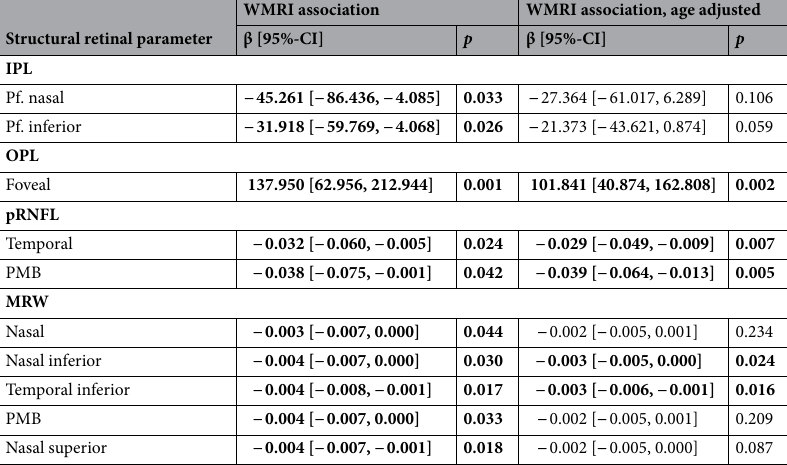
Table 3. Results of linear regression of structural retinal parameters and white matter lesions volume ratio index in patients with cerebral small vessel disease. Associations between retinal parameters and WMRI were assessed using linear regression. Model 1: univariate regression, Model 2: multivariable regression adjusted for age. Significant associations ( p < 0.05) are displayed in bold. In this table, only parameters are listed with a p value < 0.05 in at least one linear regression model. Further results are listed in the supplement. The volumes of the macular layers correspond to the foveal and parafoveal volumes (3-mm-circle). WMRI, white matter lesions volume ratio index; β, standardized coefficient; CI, confidence interval; IPL, inner plexiform layer; pf., parafoveal; OPL, outer plexiform layer; pRNFL, peripapillary retinal nerve fiber layer; PMB, papillo-macular bundle; MRW, Bruch’s membrane opening-minimum rim